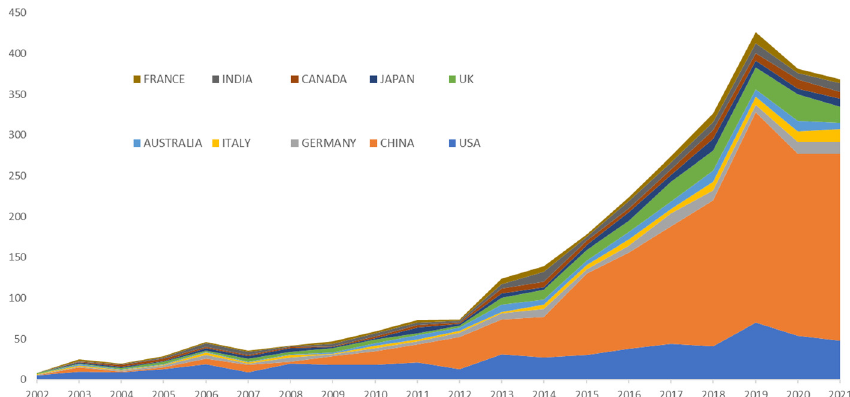
Figure 2. Stacked area charts of global publications (Top 10).